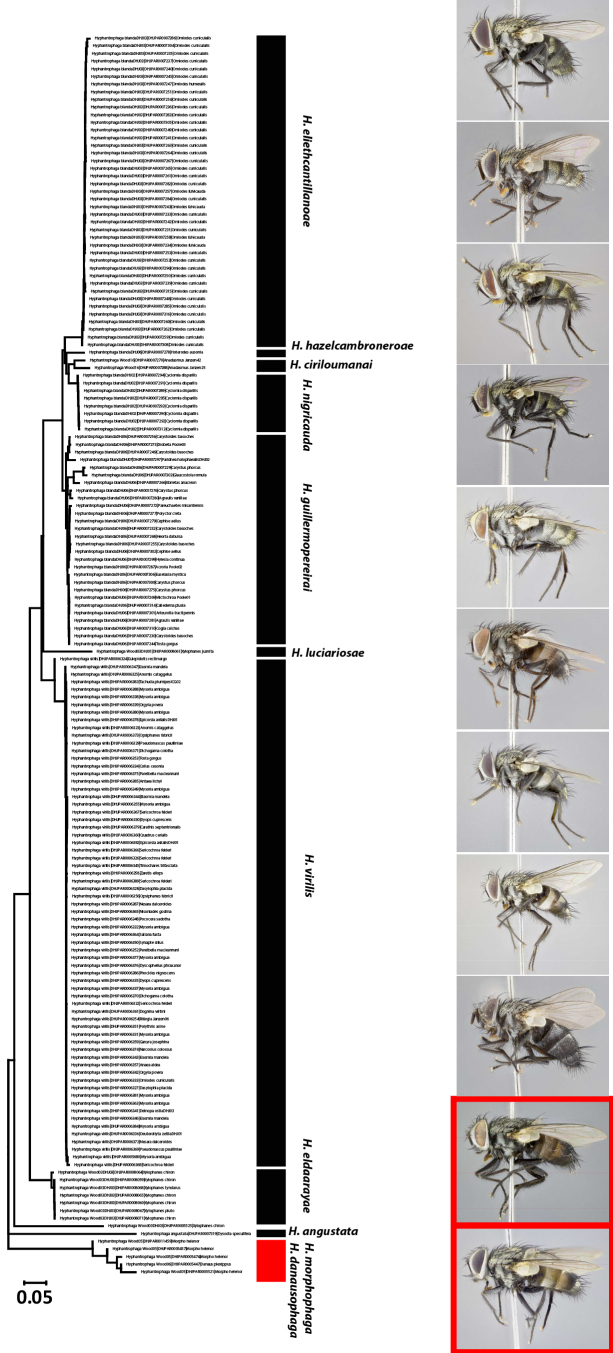
ITS2 NJ tree for Hyphantrophaga of ACG. Tip labels are interim species name|sample accession|host family.